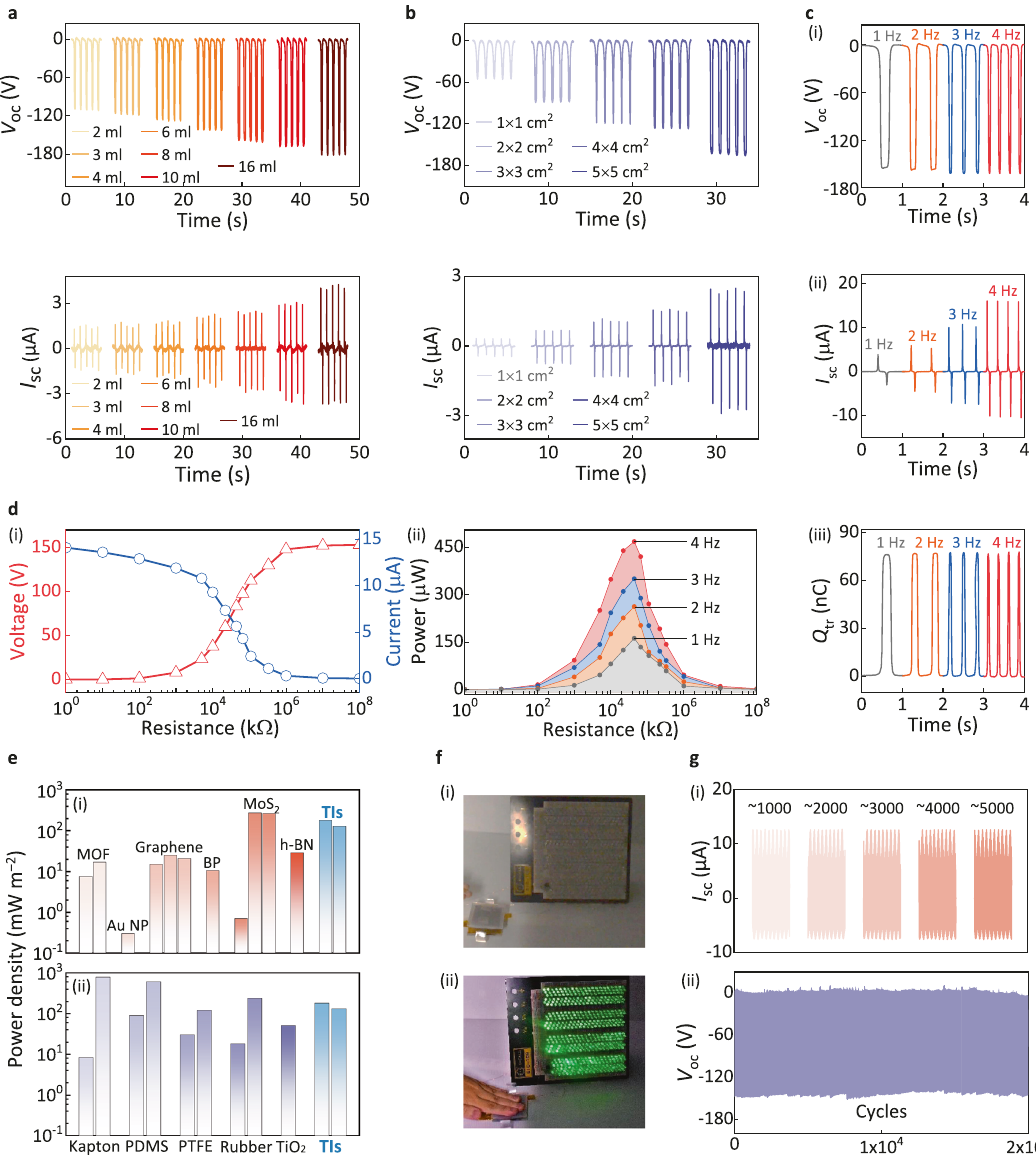
Fig. 4 Electric performance characterizations of the TI-TENG. a Output voltage and current signals of solution-based TI-TENGs with various coating doses of Bi 2 Te 3 NP colloid from 2 to 16 mL. b Output voltage and current signals of the solution-based TI-TENGs with various areas from 1 × 1 to 5 × 5 cm 2 . c Output properties of the solution-based TI-TENG (8 mL, 5 × 5 cm 2 ) depending on different operating frequencies. d Output voltage and current signals (i) of the solution-based TI-TENG as a function of various resistances, also the corresponding output power (ii) under different measurement frequencies. e Comparison plots of the output power density among previously reported TENGs based on (i) emerging nanomaterials, (ii) conventional materials, and TIs (Bi 2 Te 3 and Bi 2 Se 3 ). f Optical image of the (i) in-series LEDs and (ii) LEDs lit by a solution-based TI-TENG. g Endurance test of the TI-TENG under the continuous operation of (i) 5000 and (ii) 20,000 cycles. Source data are provided as a Source Data fi